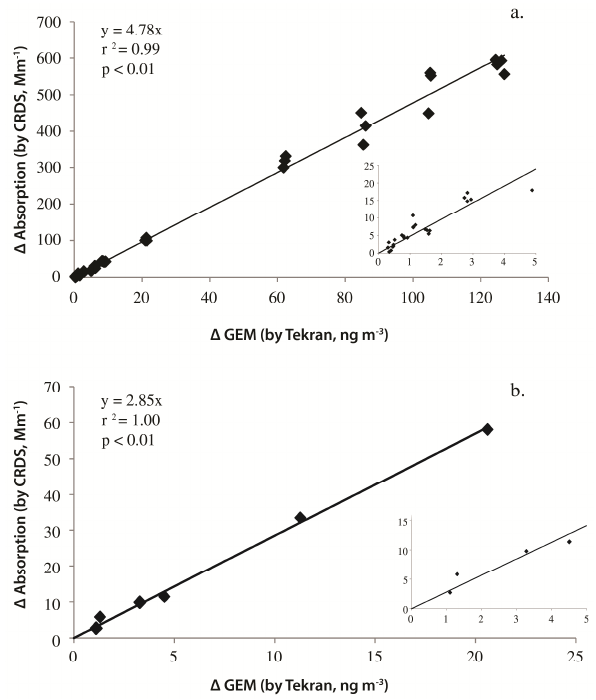
Fig. 3. (a) Scatterplots between Tekran and CRDS measurements during a calibration in Hg-free air performed 14 July 2011. (b) same as (a) for measurements on 19 July 2012. The insets for each graph show data in the range of 0 to 5ngm − 3 only.